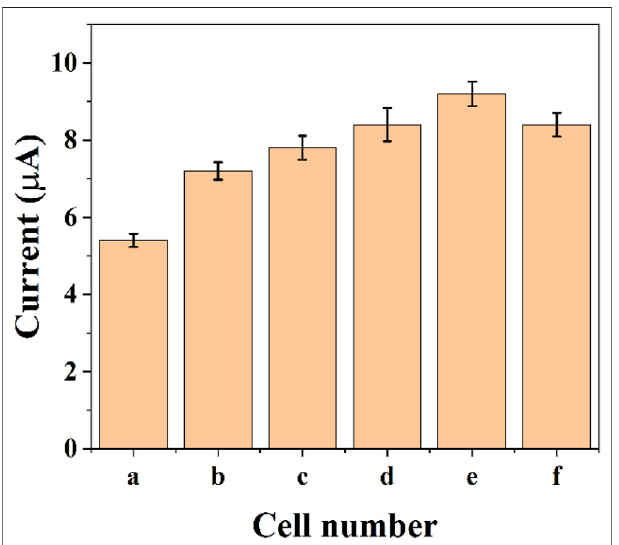
FIGURE 4 | Reduction peak current of graphene- E. coli /GCE at PBS with1 × 10 5 CFU (A) , 5 × 10 5 CFU (B) ,1 × 10 6 CFU (C) , 5 × 10 6 CFU (D) ,1 × 10 7 CFU (E) , and 5 × 10 7 CFU (F) ( n (cid:2) 3).